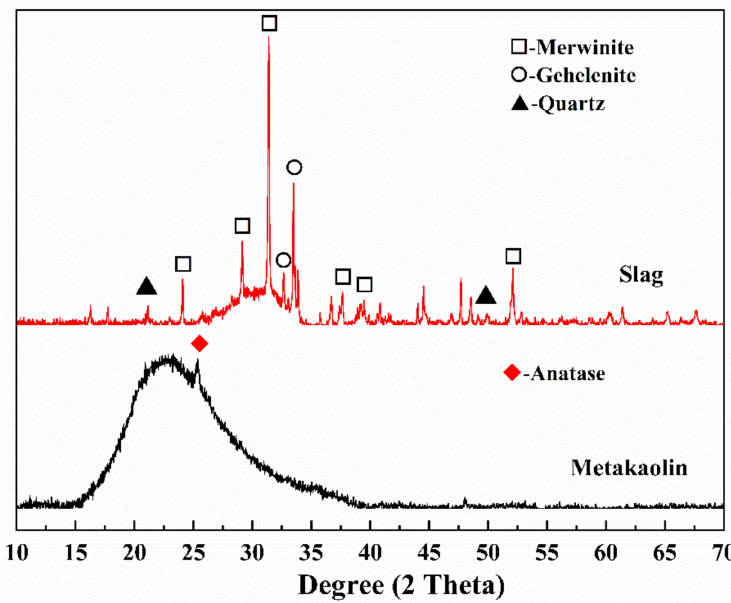
Figure 2. XRD patterns of slag and